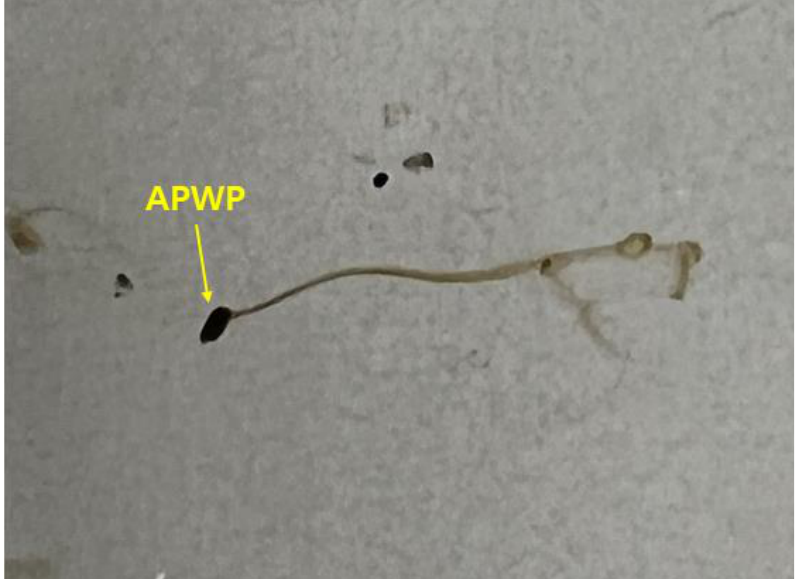
Figure 3. Dissolution of bitumen in APWP by chloroform. A TRWP and an APWP with similar size and shape were selected, and chloroform was dropped on them (Figure 4). After the chloroform treatment, the TRWP still maintained its initial shape but the APWP split into pieces and the degree was more severe by increasing the chloroform drop. When the whole bitumen part of an APWP was totally dissolved in chloroform, the APWP shape disappeared and aggregate (broken stone) in the APWP was appeared. Hence, we can conclude that APWPs mixed with TRWPs are removed by chloroform treatment. By the chloroform treatment, binder components such as bitumen in APWPs dissolve and the stone components with high density settle